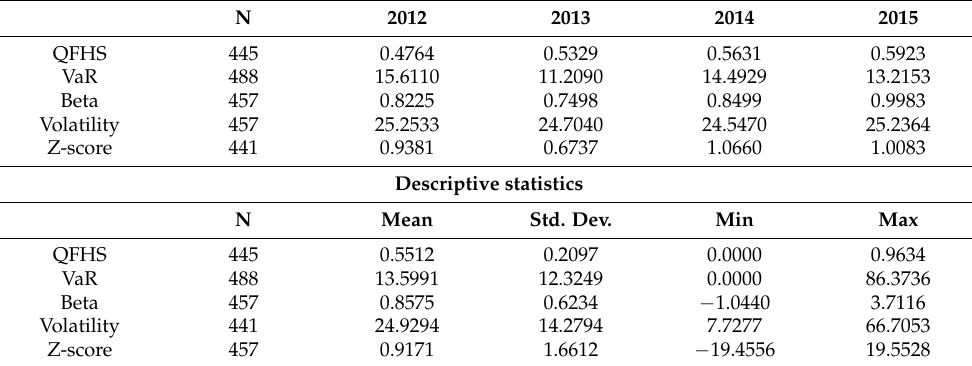
Table 1. Evolution of the risk-representative variables.